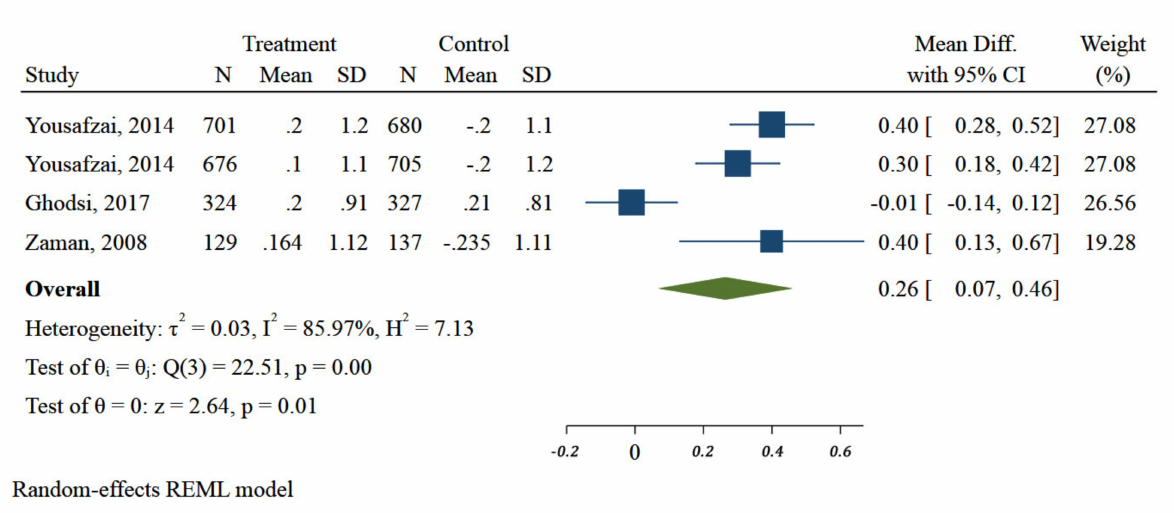
Figure 6. Impact of different community-based nutrition interventions on Weight-for-Height Z-score of children under 5 in Eastern Mediterranean Region.